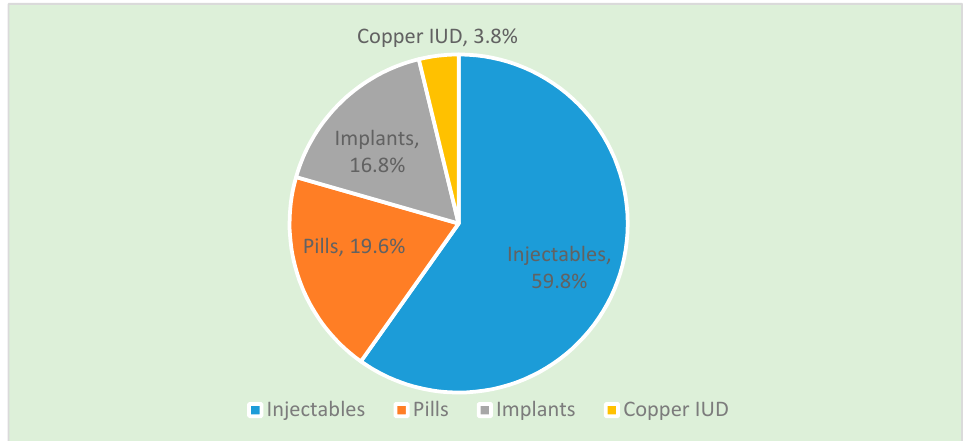
Figure 1. Contraceptive methods chosen by the study participants.